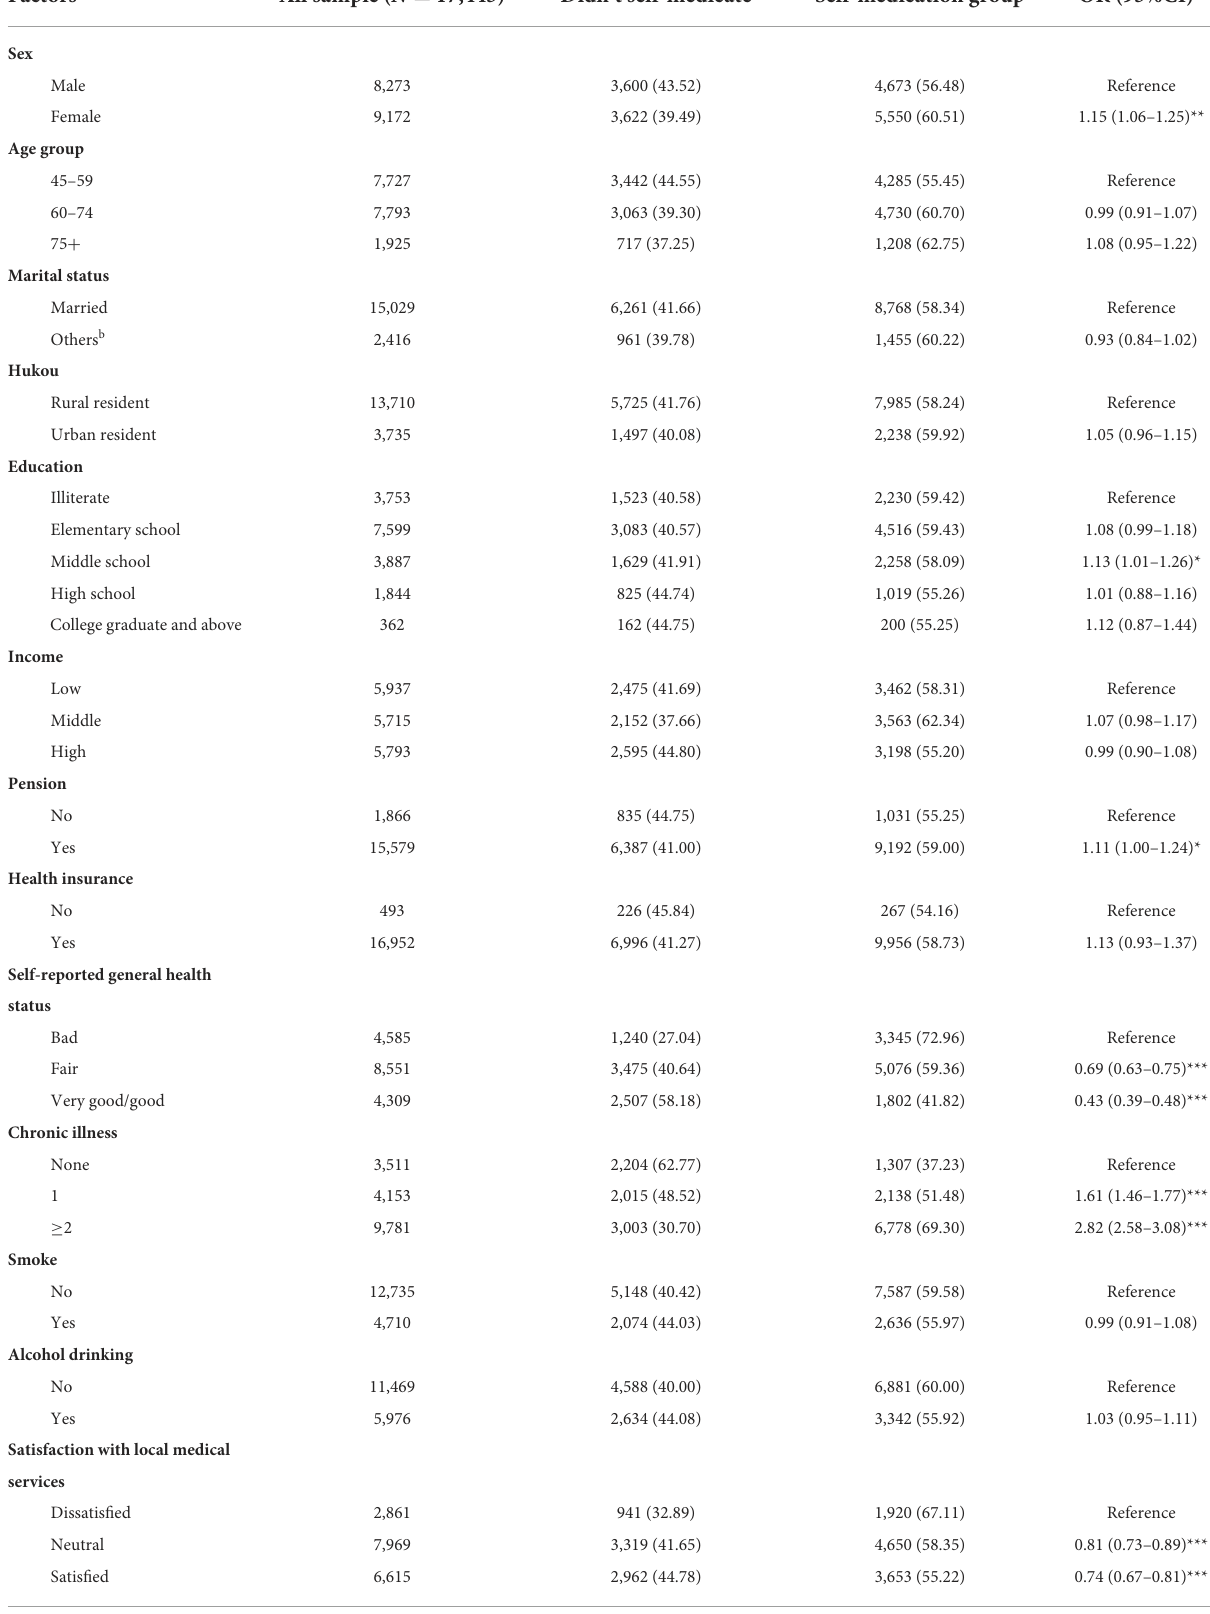
TABLE 1 Associations between factors and self-medication among elder Chinese, 2018 ( N ,